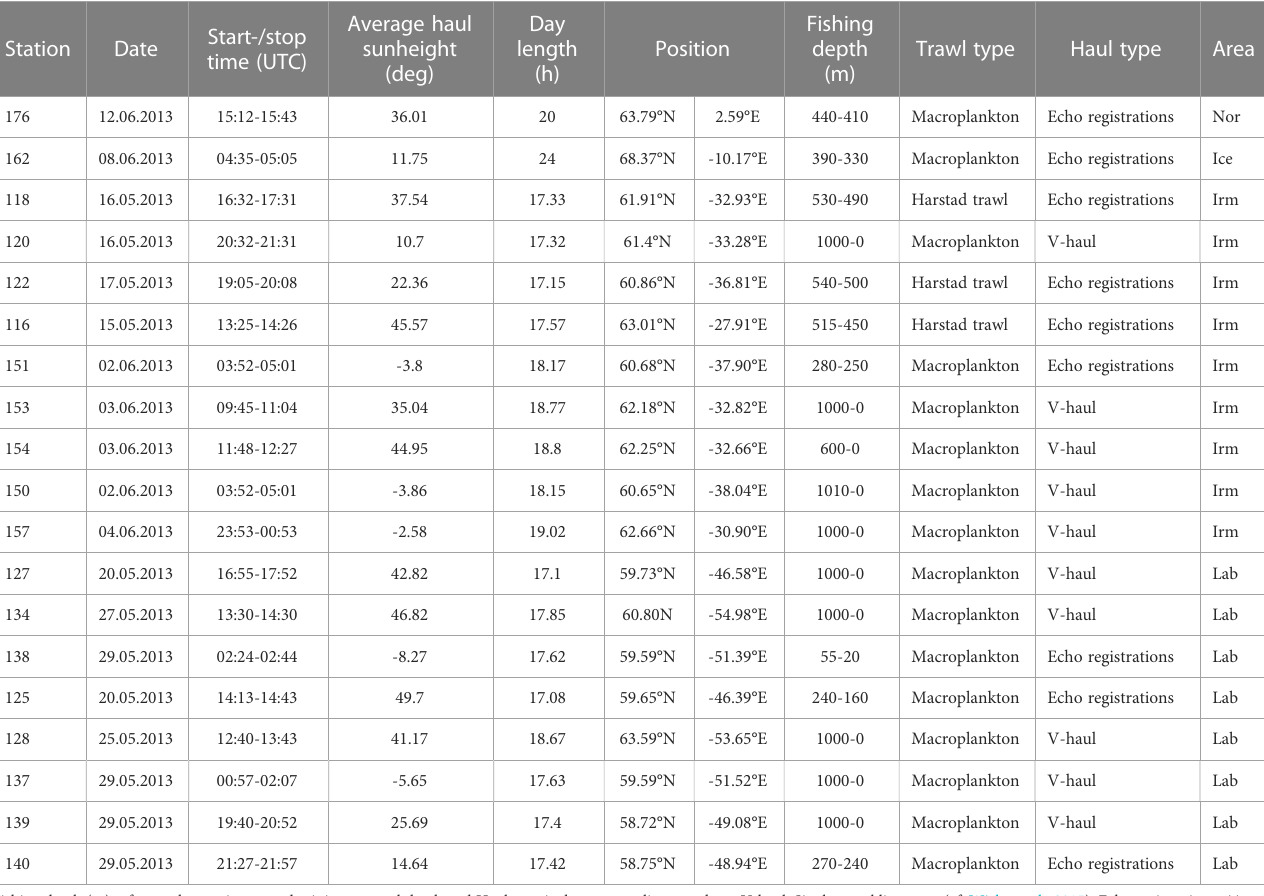
TABLE 1 Overview of trawl stations for the collection of B. glaciale stomach data as well as date and time of day (UTC) the trawling took place.